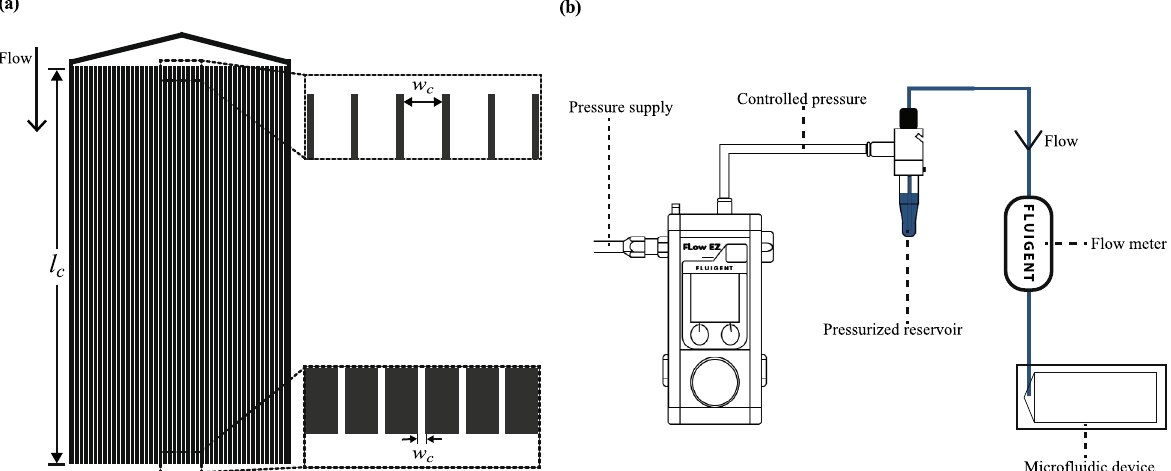
Figure 1. ( a ) Schematic of the microfluidic device with an inlet reservoir and 165 parallel microchannels. The channels are ∼ 5 cm long and taper from 40 μm at the inlet to 4 μm at the outlet, with a taper angle of ∼ 0.02 ◦ . The insets show the channel width at inlet and outlet; the outlet region is where the evolution of fluorescence intensity is monitored over time. ( b ) Flow test setup: a constant pressure is applied to the reservoir containing the suspension by a clean air supply. The flowrate is measured per unit time by an inline flow meter and the data is collected online. The driving pressure is approximately equal to the pressure drop across system since the fluid exiting the microfluidic device is at atmospheric